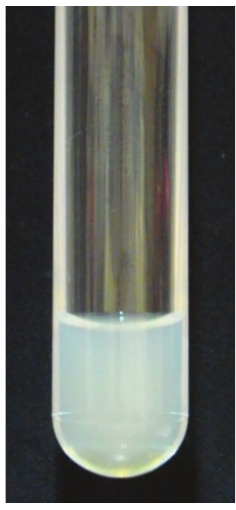
Figure 4: Ascitic fluid was milky, clear, and odorless.